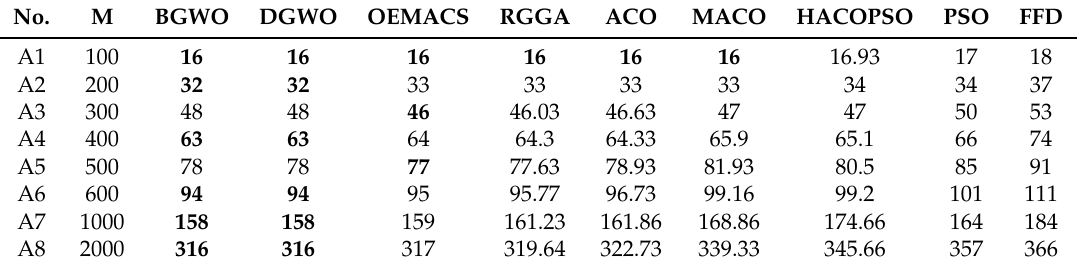
Table 1. Experimental results for the bottleneck resource test in a homogeneous environment (the best results are in bold).